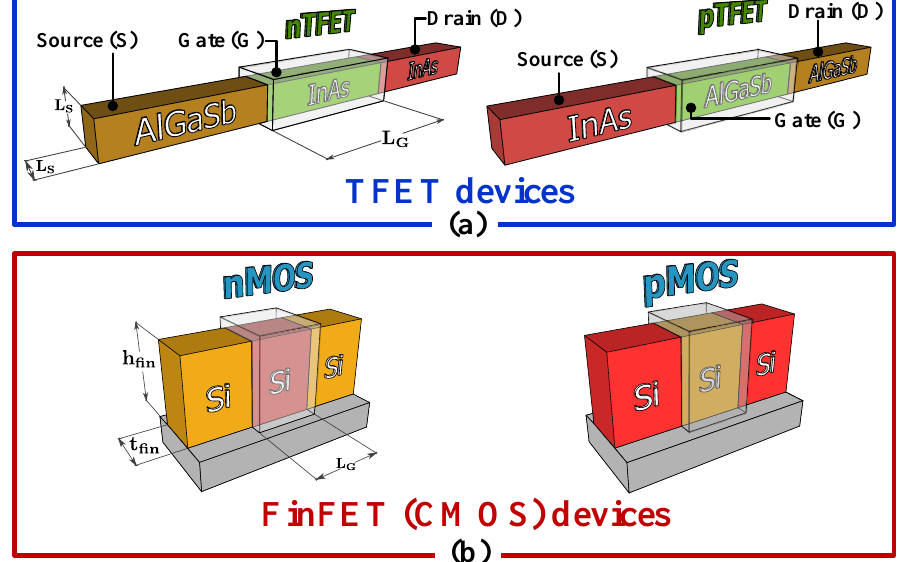
Figure 1. Sketch of the device structure for n- and p-type ( a ) TFETs and ( b ) FinFET devices. The superior SS of the TFET can be exploited in two different ways: (1) equalizing the threshold voltage of the TFET to that of the FinFET in order to obtain a lower off-current and lesser static energy dissipation, or (2) by setting the same off-current in both devices so that the TFET is able to achieve a higher on-current at lower supply voltages [23]. This